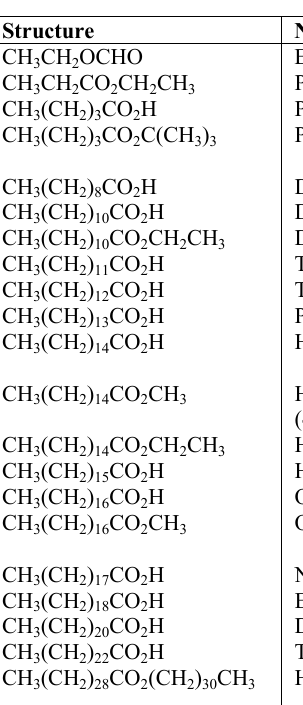
Table 3. Saturated Unbranched Carboxylic Acids and Esters.